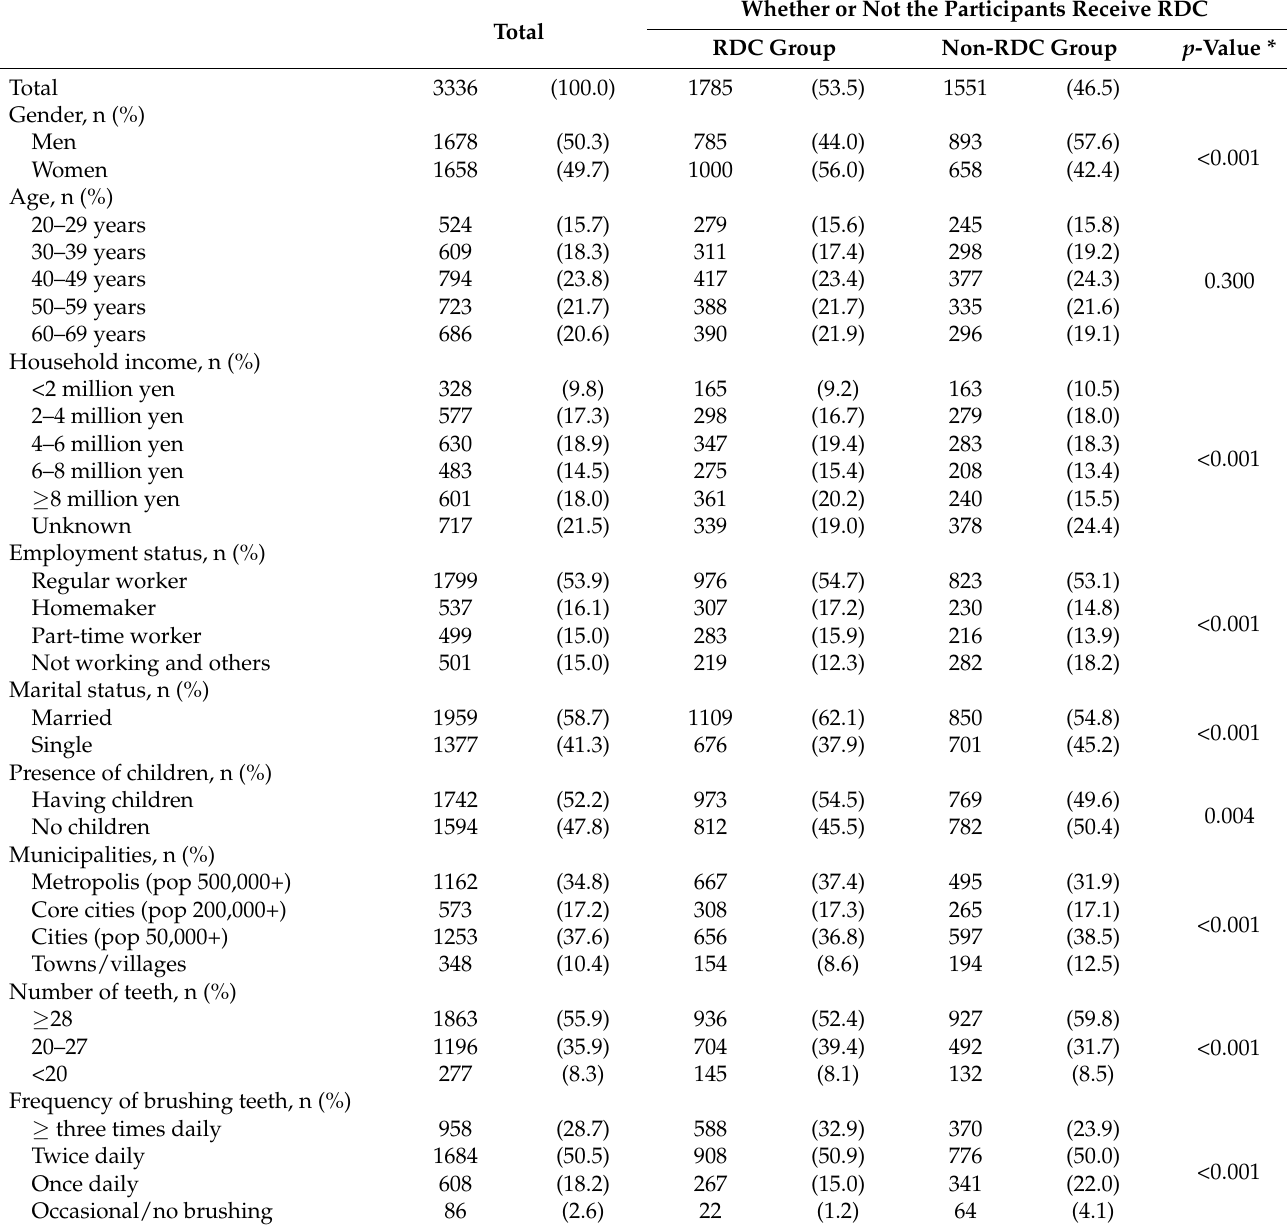
Table 1. Demographic characteristics of the study participants and the number and proportion of the RDC and non-RDC